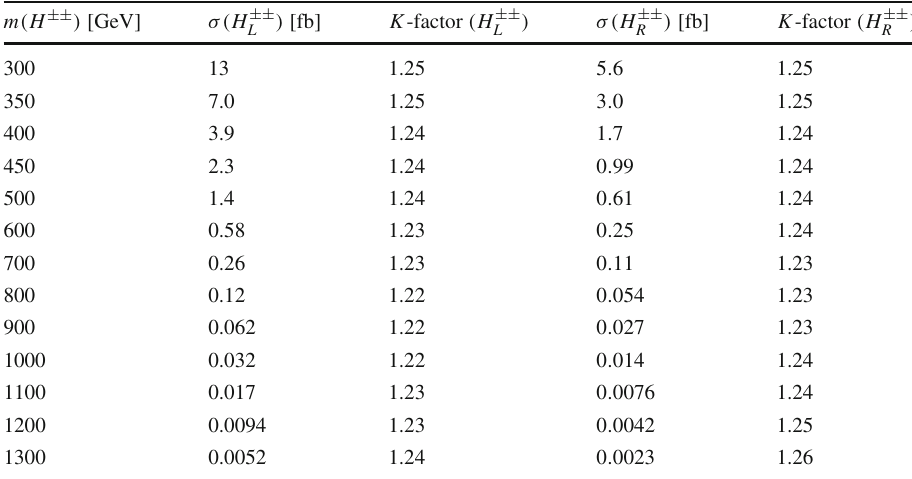
Table 2 NLO cross-sections for the pair production of H ++ H −− H −− and H ++ in pp √ L L R R s = 13TeV, collisions at together with the correction factors ( K = σ NLO /σ LO ) used to obtain those values from the LO prediction. These K -factors are calculated by the authors of Ref. [9] using the CTEQ6 PDF